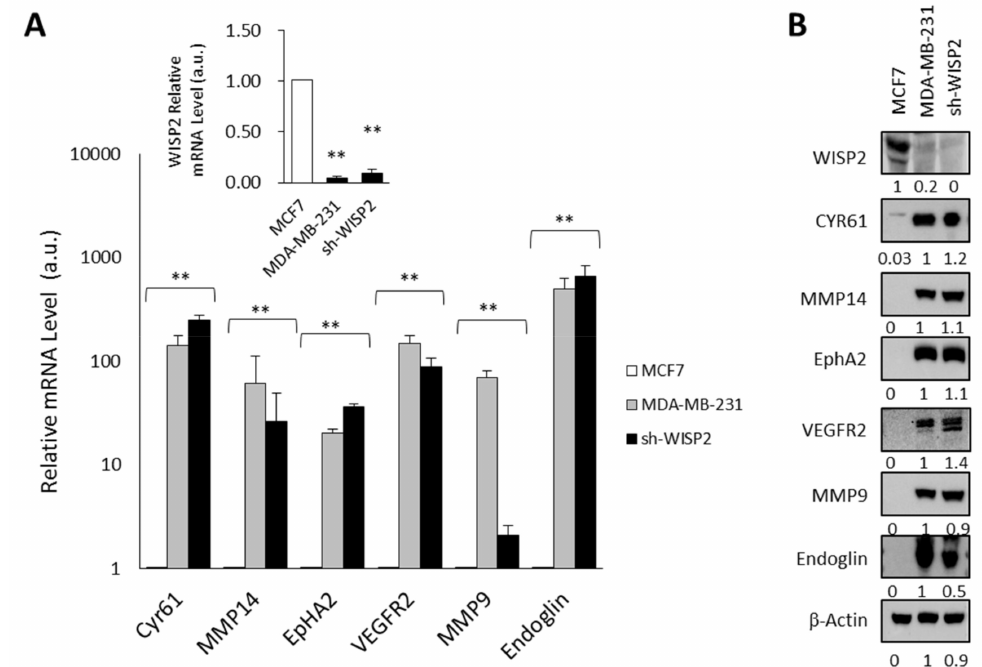
Figure 1. Loss of WISP2 induces angiogenic-associated gene expression ( A ) RNA was isolated from human breast cancer cell lines and angiogenic gene expression was analyzed by qRT-PCR. The results, after normalization as described in Materials and Methods, represent the relative transcript levels among these different cell lines tested and are expressed as mean ± SEM from three independent experiments. The inset shows WISP2 mRNA levels. The values indicate the changes for the indicated samples compared to MCF7 cell line. ** p < 0.01 ( B ) Protein extracts of different cell lines were prepared and tested by Western blotting for angiogenic protein expression. The levels of β -actin in cell lysates were measured by Western blotting and included as a loading control. Levels of proteins were calculated by densitometry and listed beneath the bands. The original western blots can be found in File